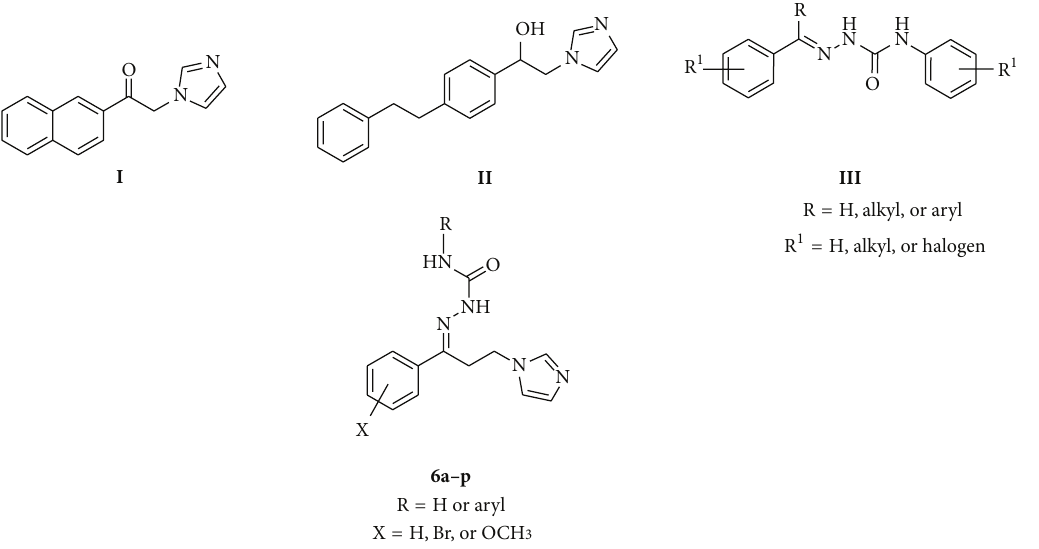
Infrared (IR) spectra were recorded as KBr pellets with JASCO FT/IR-6100 spectrometer and values are represented in cm −1 . 1 H NMR (500 MHz) and 13 C NMR (125 MHz) spectra were carried out on Jeol ECA 500 MHz spectrometer using TMS as an internal standard and chemical shift values were recorded in ppm on 𝛿 scale. The 1 H NMR data were represented as follows: chemical shifts, multiplicity (s; singlet, d; doublet, dd; doublet of doublet, t; triplet, m;